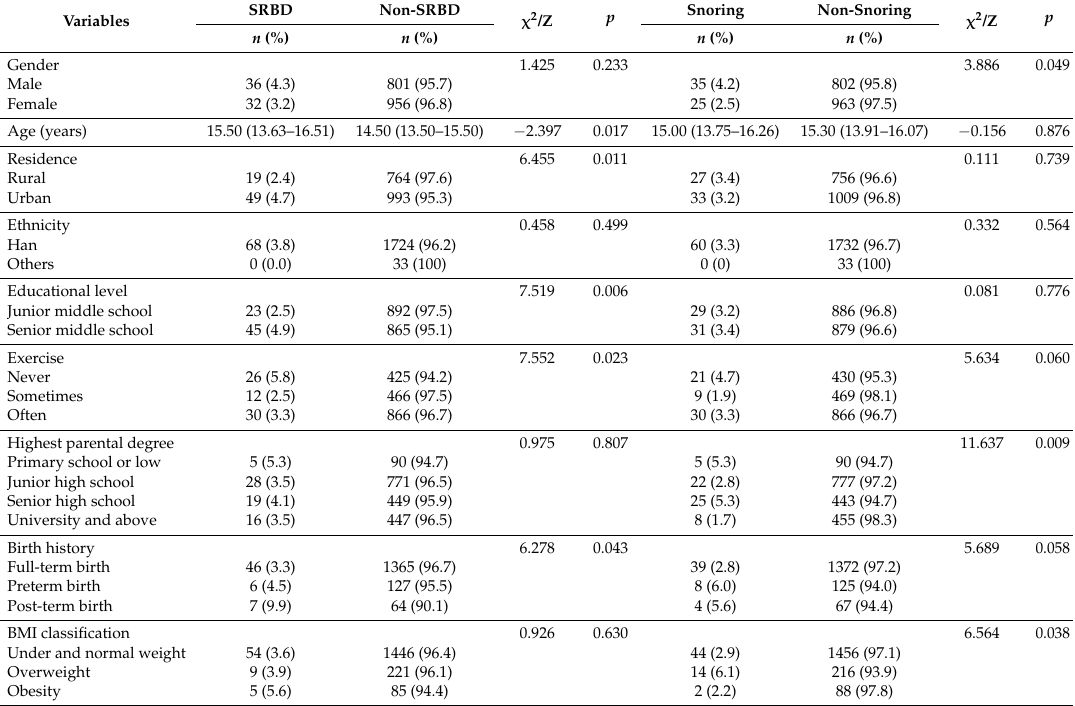
Table 1. Prevalence of SRBD and snoring among adolescents ( n = 1825).